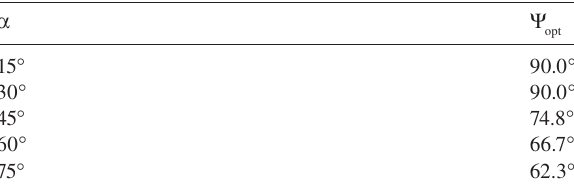
Effect of L/R ratio on the optimum fi ber orientations.